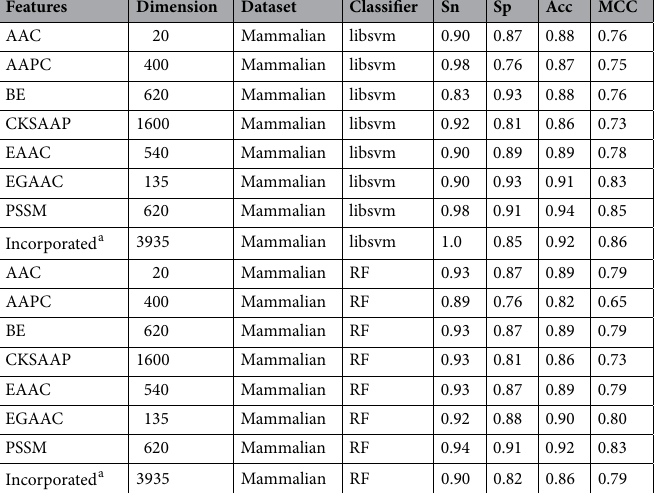
Table 2. Performance on mammalian dataset. means AAC + AAPC + BE + CKSAAP + EAAC + EGAAC +